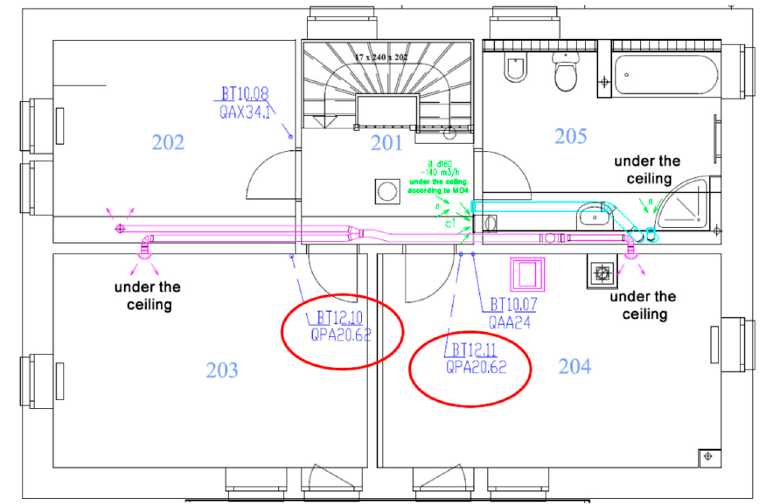
Figure 6. The ground plan of the first floor of the SH with the location of the sensors for CO 2 measurement.